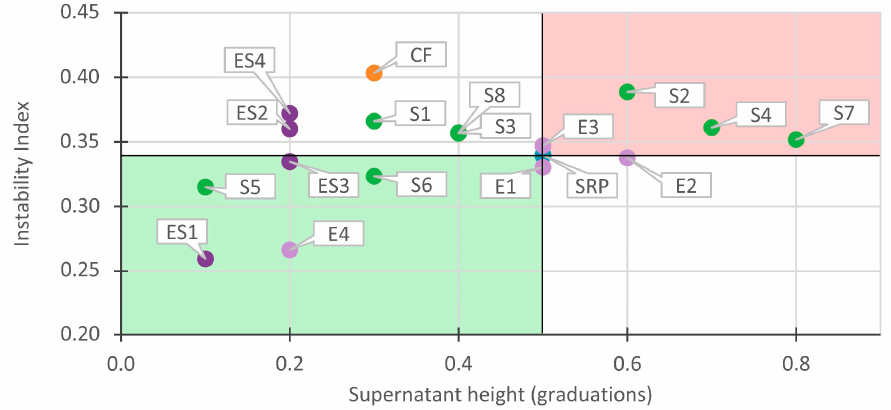
Figure 8. Correlation between the instability index and supernatant height in SRP with 0.2% of dis-